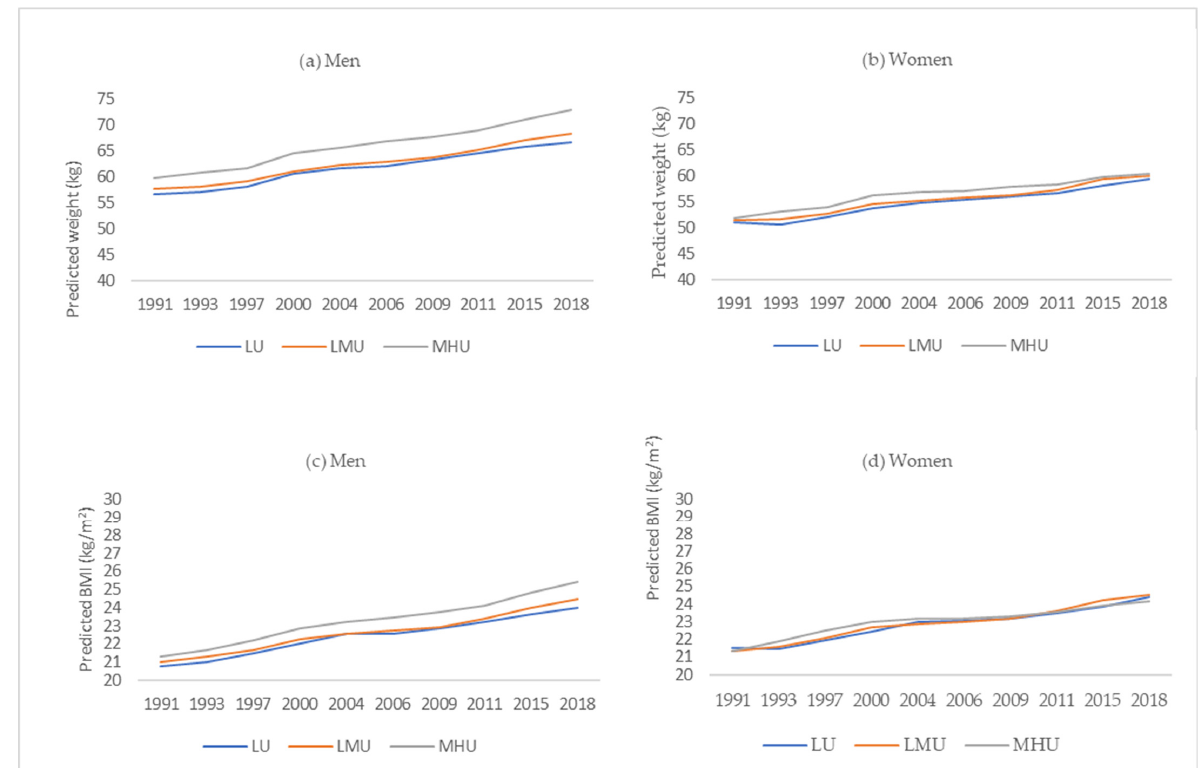
Figure 2. Predicted weight in men ( a ) and women ( b ) and predicted BMI in men ( c ) and women ( d ) by urbanization trajectories. Predicted weight/BMI was generated from multilevel mixed models, controlled for survey year, education level, smoke, drinking, age, income, dietary energy intake, physical activity, entry age, and entry weight/BMI. Abbreviations: BMI, body mass index; LU, low urbanization; LMU, low–middle urbanization; MHU, middle–high urbanization.